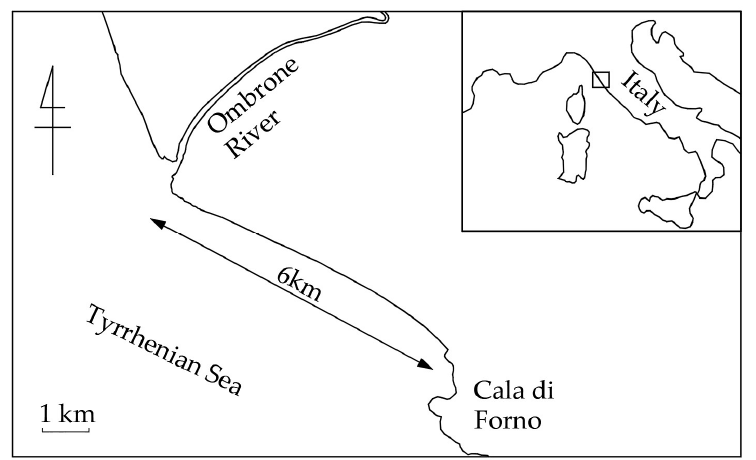
Figure 11. Ombrone River delta in Italy.